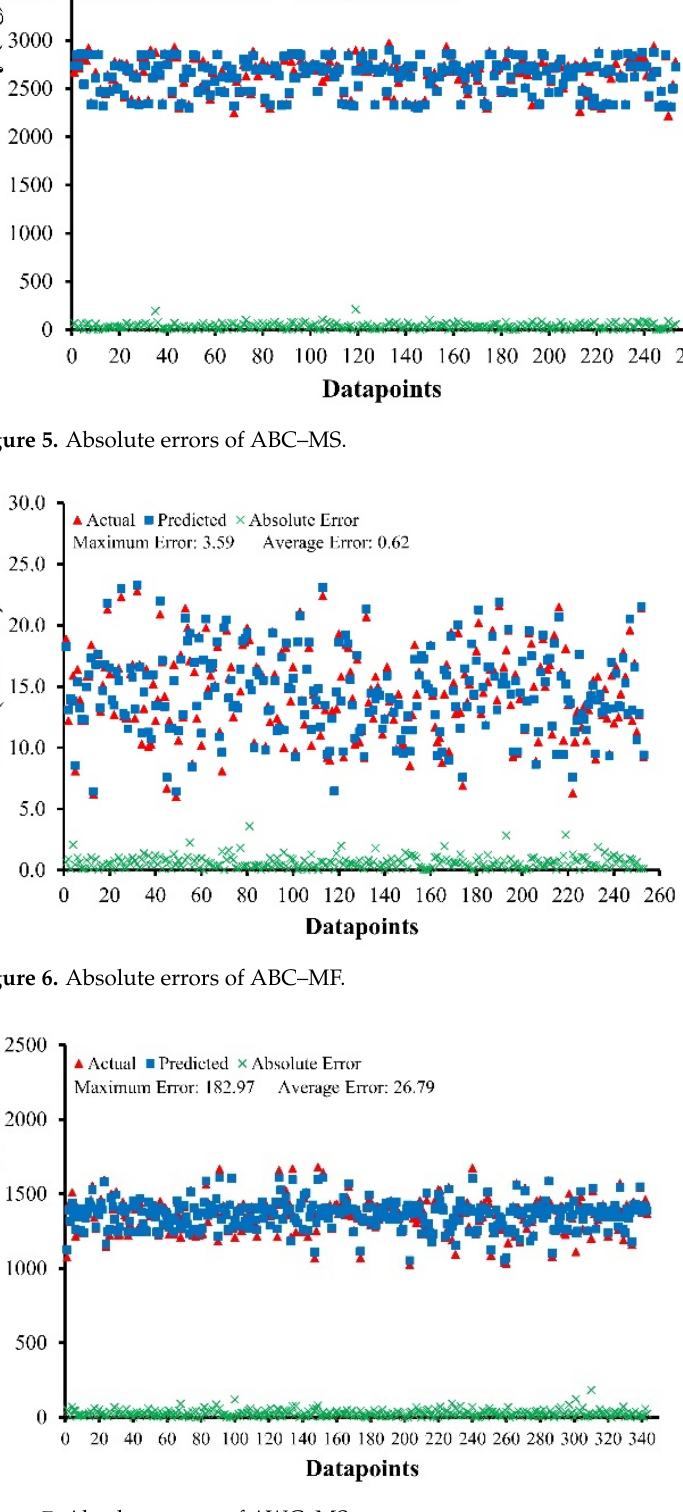
Figure 7. Absolute errors of AWC–MS.